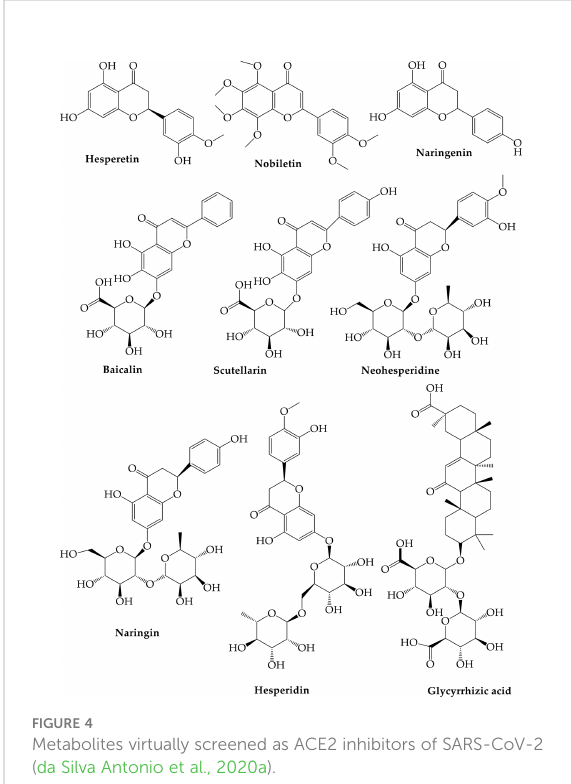
FIGURE 4 Metabolites virtually screened as ACE2 inhibitors of SARS-CoV-2 (da Silva Antonio et al., 2020a).